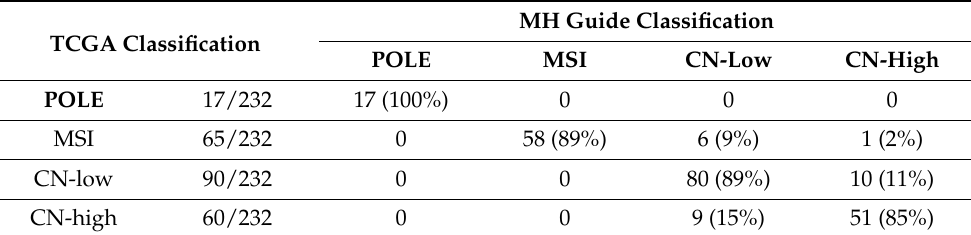
Table 1. Comparison of EC molecular subtype designation based on TCGA [12] and MH Guide. Cases according to TCGA classification were reclassified using the MH Guide algorithm and indicated as patients in the respective EC subtypes. In parentheses, the percentage of subclassified patients is given relative to the total number in the subclasses as defined based on TCGA.